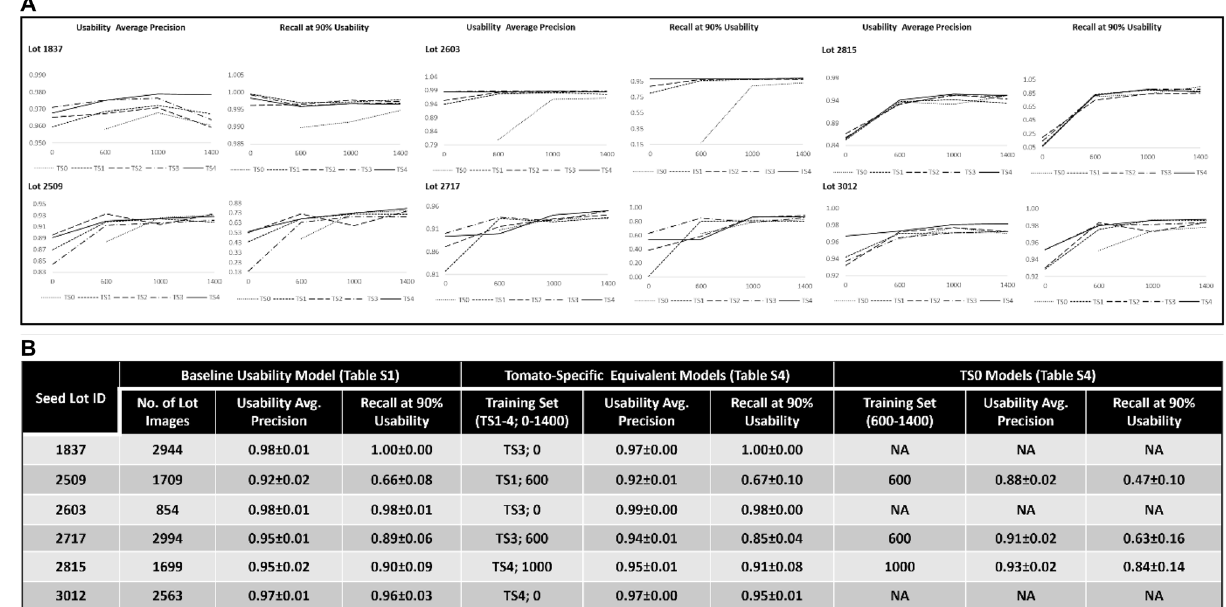
Figure 4. Counterbalancing lot-specific data reduction with crop-level auxiliary data. Usability of six tomato seed lots was predicted by 19 separate classifiers that had been trained with a matrix of accumulative auxiliary training sets of 0, 6, 10, 16 or 20 different tomato seed lots (respectively, TS0-4) combined with lot-specific data (0, 600, 1000 or 1400 images, weighted by phenotypes). All combinations but ‘TS0 and 0’ (no training data) were trained with. ( A ) ‘Usability average precision’ and ‘recall at 90% usability’ were generally improved by training set diversification, but in some cases, this led to a decrease in classification performance, probably due to imbalanced training set expansion and the stochasticity of the training process (see text for more details). ( B ) A comparison between the baseline usability model and the Tomato-specific equivalent models, trained with crop-level auxiliary data, demonstrated the competence of the latter to generate similar performances with significantly less-up to exclusion—of specific data. TS0 models, trained by the lot-specific component of the ‘tomato-specific equivalent model’ training sets generated inferior performances, reflecting the added-value of the auxiliary data. NA-non-applicable, where TS1-4 equivalent models used no specific